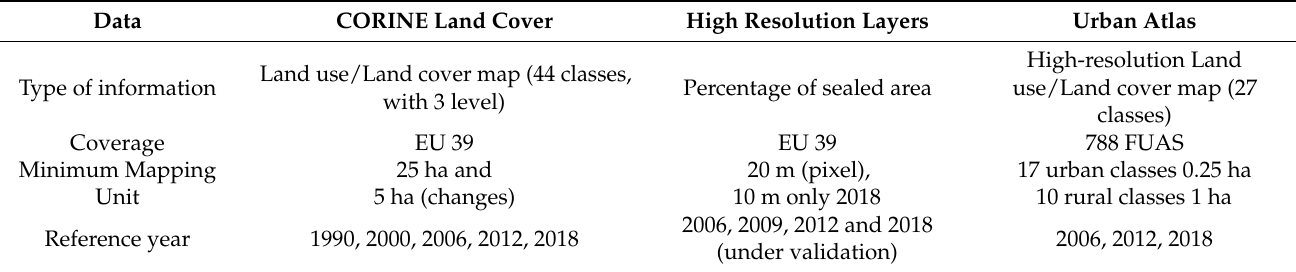
Table 1. Relevant Copernicus data related to land